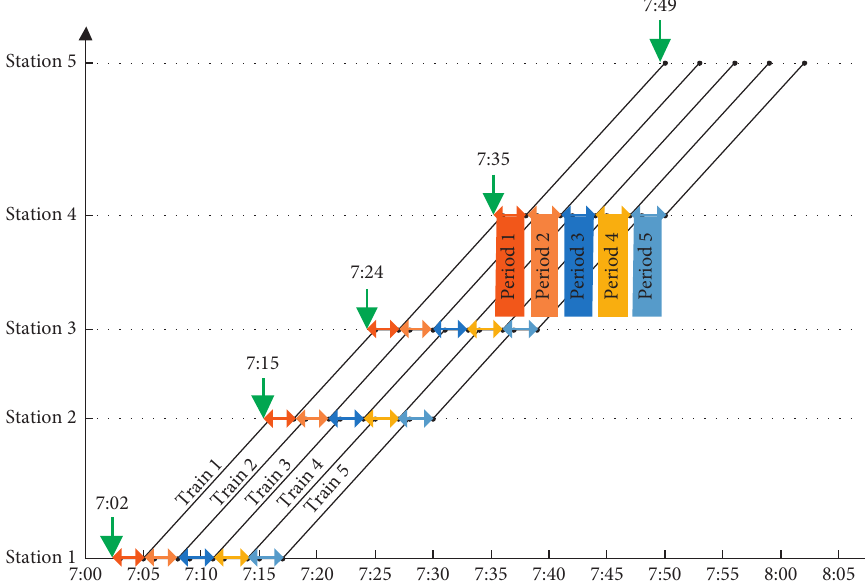
Figure 4: The timetable and flow control periods in the numerical study. Table 5: The passenger arrival rate (unit: pax/minute).